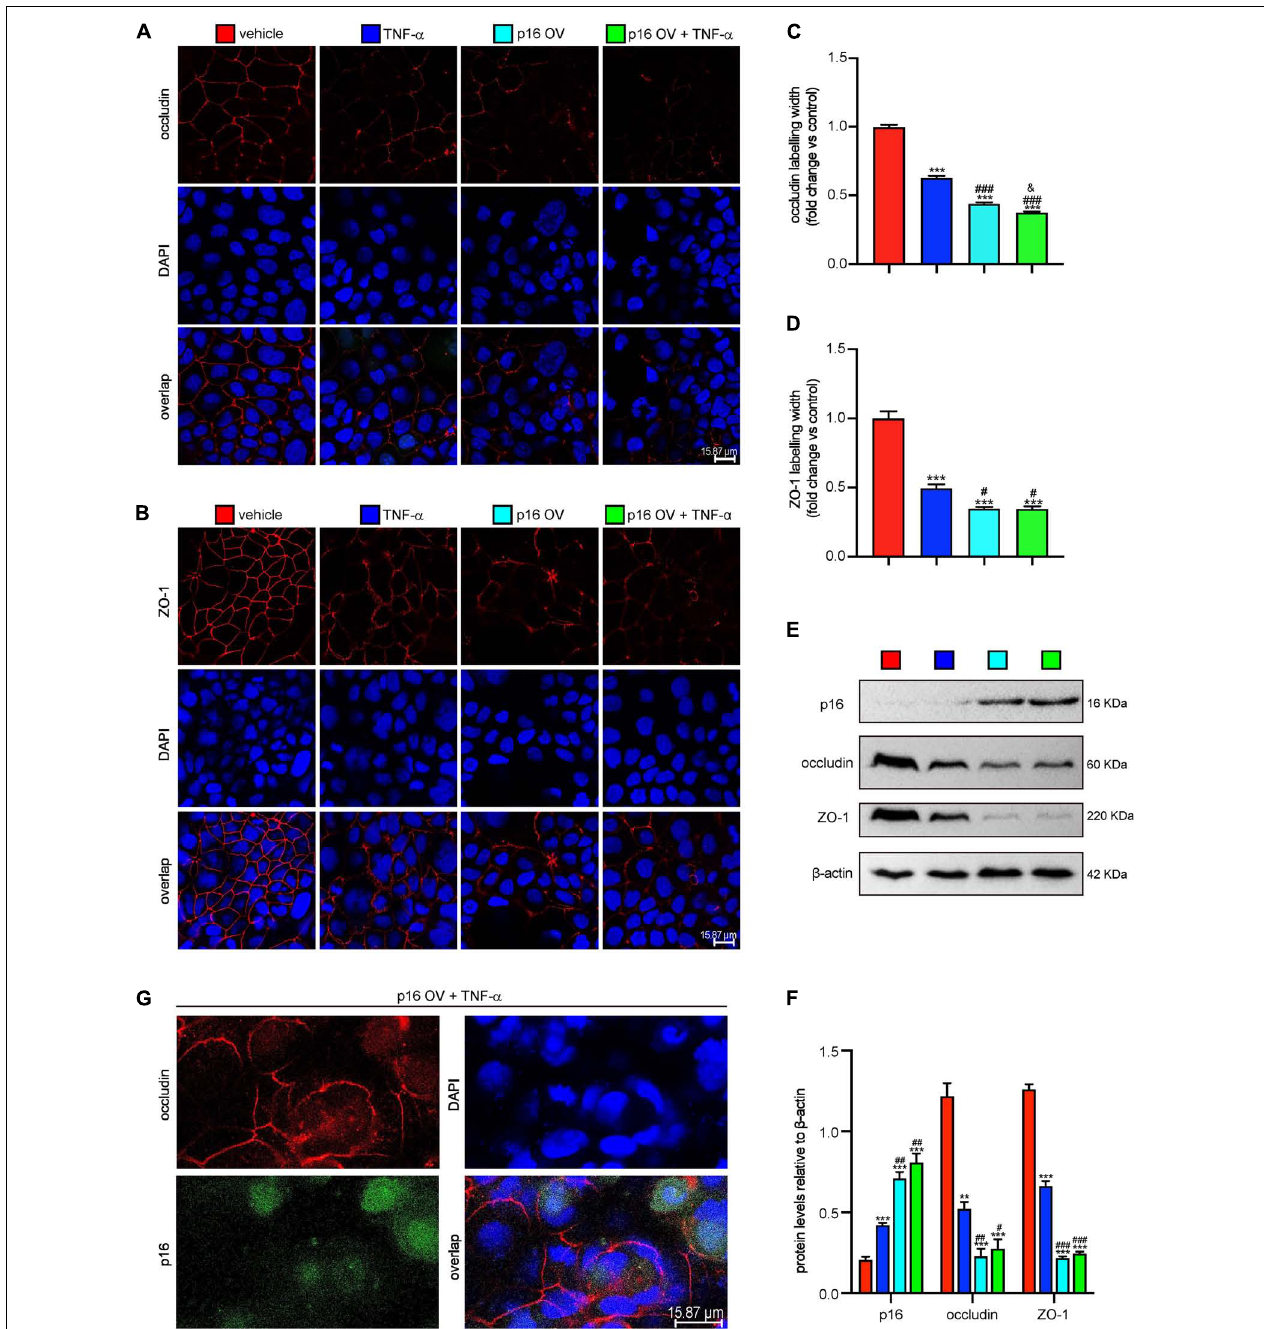
FIGURE 4 | Accumulated p16 in Cacao-2 cells blocked the repair of TJ after TJ was damaged by TNF- α . The Cacao-2 cells were transfected with GFP-labeled Flag-p16– overexpressed ( p16 -OV) or vehicle adenovirus and then treated with or without 10 ng/mL TNF- α for 24 h. Immunofluorescence staining was introduced to detect the expressions of occludin and ZO-1. (A) Representative micrographs showing immunofluorescence for occludin, with DAPI staining the nuclei. (B) Representative micrographs showing immunofluorescence for ZO-1, with DAPI staining the nuclei. (C) Occludin positive width relative to control group. (D) ZO-1 positive width relative to control group. (E) Western blots for p16, occludin, and ZO-1 in Cacao-2 cells, and β -actin was used as the loading control. (F) Protein levels relative to β -actin were assessed by densitometric analysis. Cell experiments were performed with three biological repetitions per group. Statistical analysis was performed with one-way ANOVA test. Values are mean ± SEM from six determinations per group, ** p < 0.01, *** p < 0.001 compared with the vehicle group; # p < 0.05, ## p < 0.01, ### p < 0.001 compared with TNF- α –treated group, & P < 0.05 compared with the p16 -OV group. (G) Representative micrographs showing occludin and GFP-labeled p16 in p16 -OV and TNF- α –treated cells, with DAPI staining the nuclei.